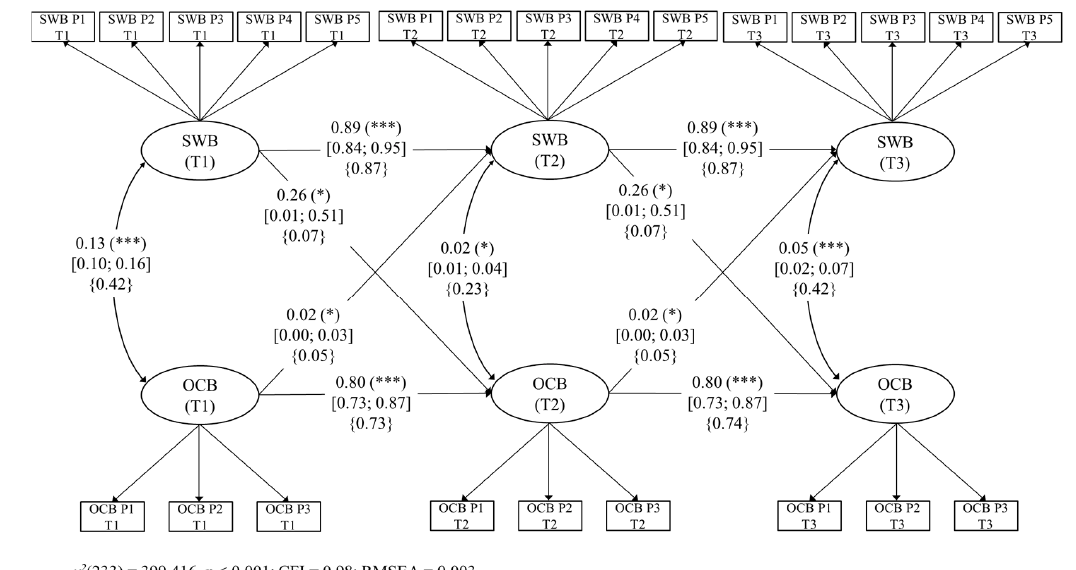
Figure 1. Model 1. Structural longitudinal model for the associations between subjective well-being (SWB) and organizational citizenship behaviors (OCBs). Coefficients shown are unstandardized paths. The unstandardized confidence intervals are reported in square brackets for significant paths. Standardized paths are shown in curly parentheses. Error terms and factor loadings are not shown to enhance visual clarity. P1: Parcel 1, P2: Parcel 2, P3: Parcel 3, P4: Parcel 4, and P5: Parcel 5. T1: Time 1, T2: Time 2, and T3: Time 3. Solid lines = significant paths. *** p < 0.001; ** p < 0.01; * p < 0.05.